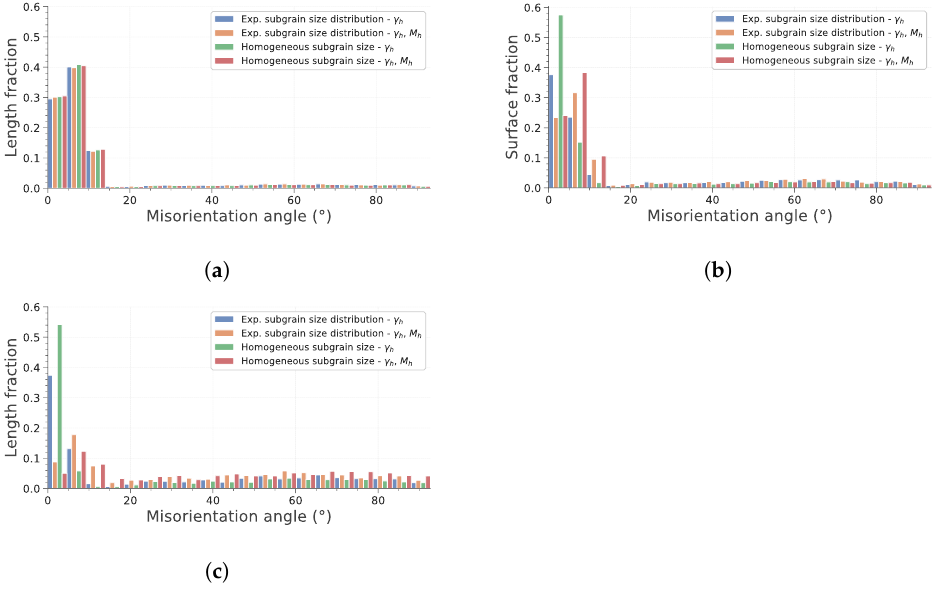
Figure 8. Disorientation histograms at three instances of the simulation. ( a ) Initial state. ( b ) After 1000 s . ( c ) Final